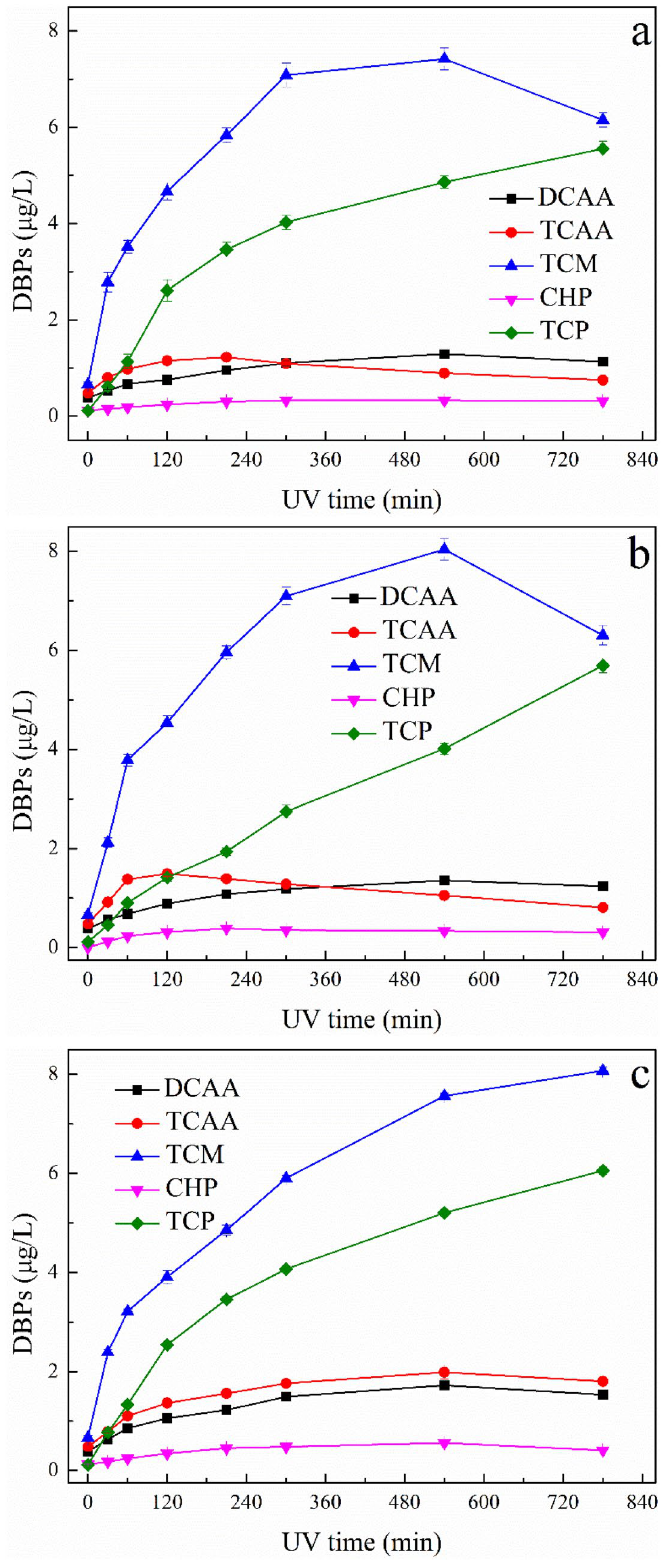
Figure 10. DBPs formations of UV/H 2 O 2 oxidized ATZ solutions: ( a ) pH = 4.0; ( b ) pH = 7.0; (c) pH =